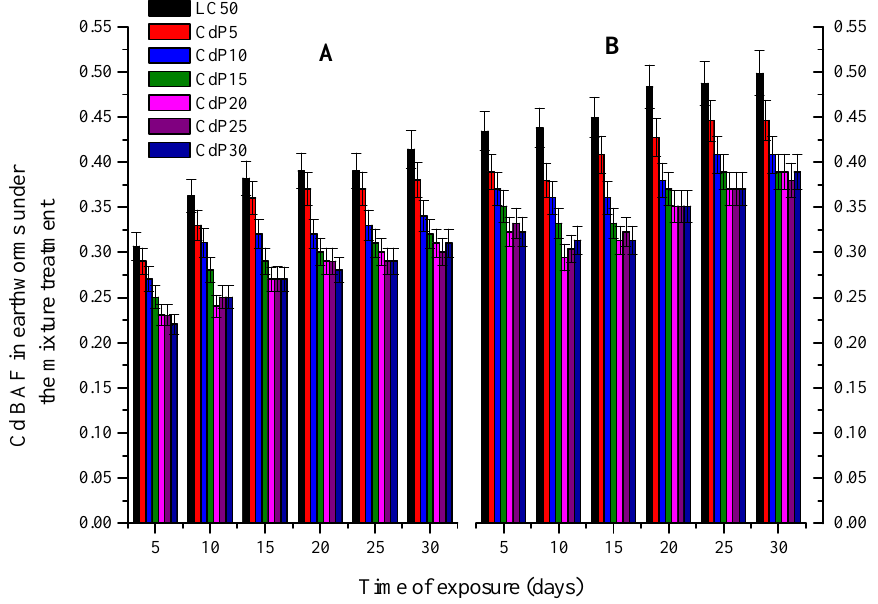
Figure 4. Bioaccumulation factor (BAF) of Cd on E fetida ( A ) and A. caliginosa ( B ) under the mixture treatment with different phenanthrene concentration with the respect to the time. Different represented bands are means of three replicates with standard error (Tukey’s Studentized Range HSD test p =